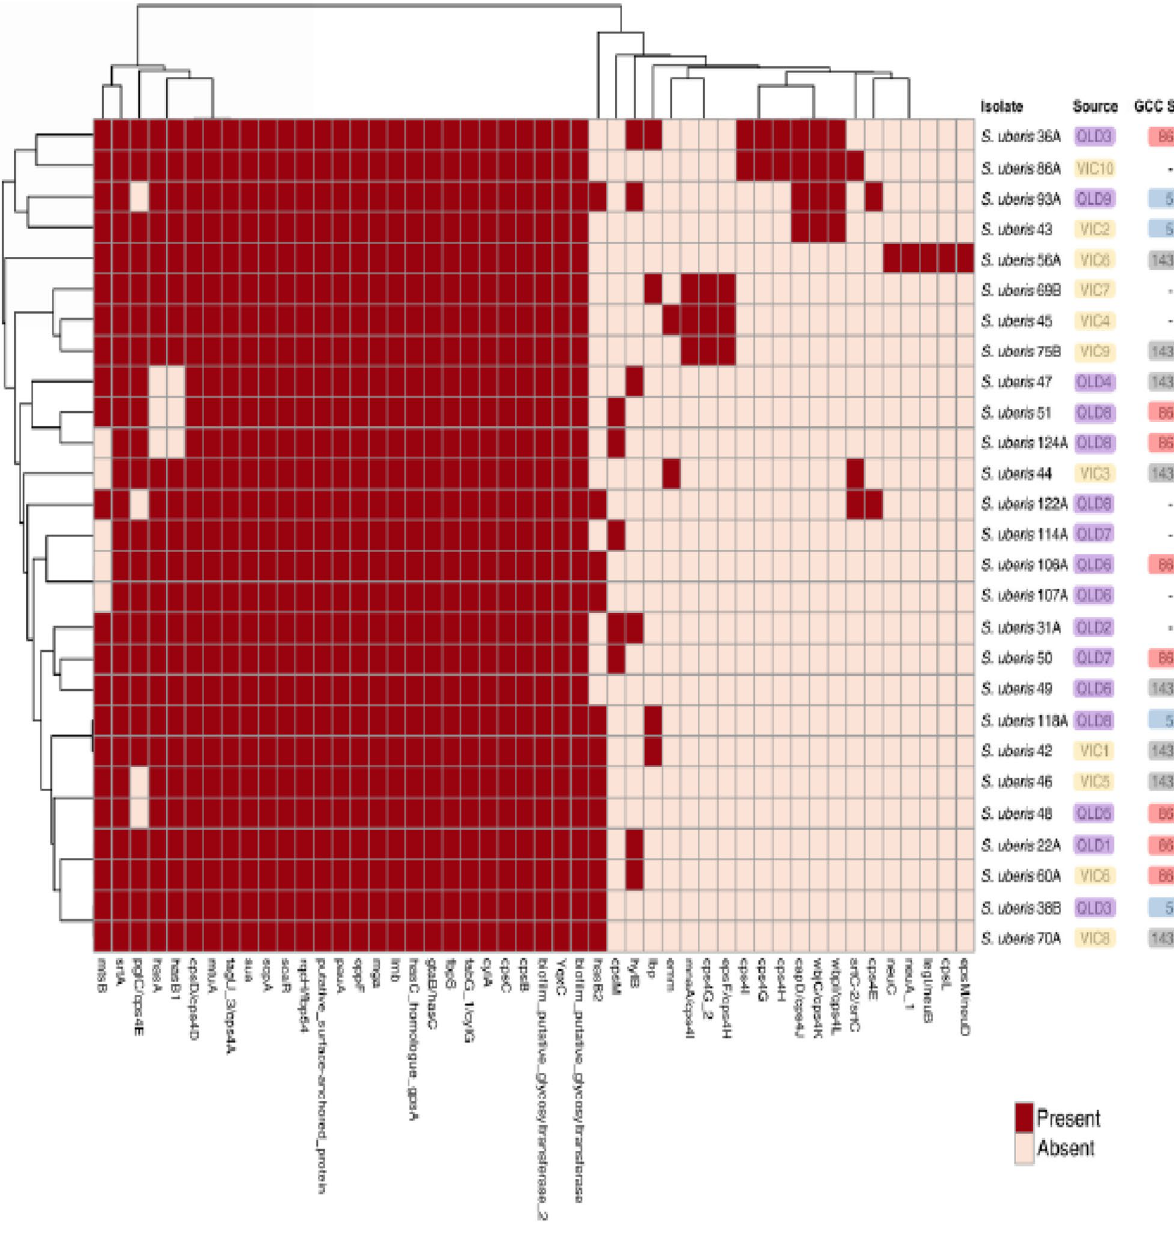
Figure 4. Heatmap showing the presence/absence of virulence and putative virulence genes (x-axis) within the S. uberis isolates identified in this study (y-axis). Presence of virulence genes shown in red, absence in light pink. Core virulence genes are found in every isolate (27/27), while accessory virulence genes are found in < 27 isolates. Victorian isolates are coloured in yellow, Queensland in purple. GCCs are coloured, GCC ST86 coloured red, GCC ST5 coloured blue and GCC ST143 coloured grey. Data generated using ABRicate version 1.0.1 (https ://githu b.com/tseem ann/abric ate) 121 with the VFDB 122 and the custom Su PVDB (Data S2). Heatmap produced using ClustVis (https ://biit.cs.ut.ee/clust vis/) 124 and Inkscape version 0.92 (https ://www.inksc